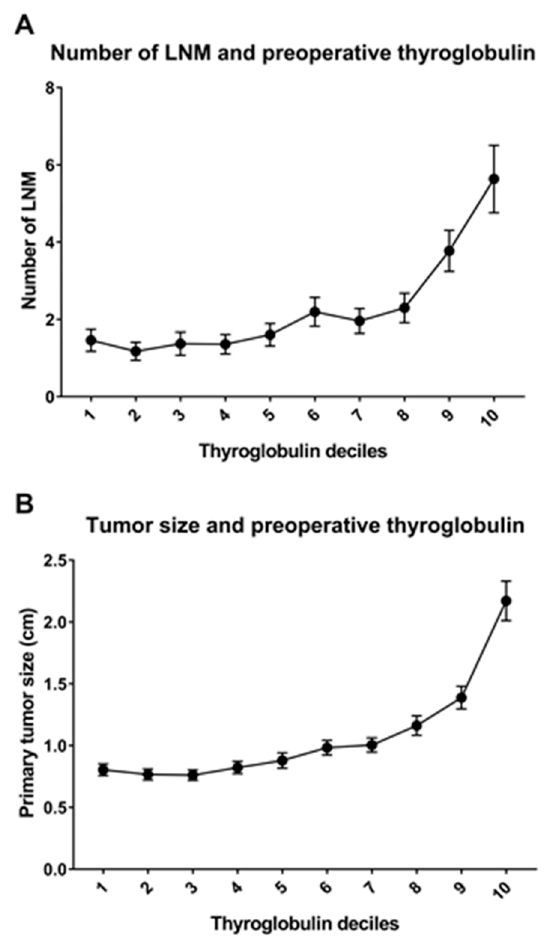
Figure 1. Correlation between tumor burden and preoperative thyroglobulin levels. There is a linear relationship between preoperative serum thyroglobulin and ( A ) the number of LNM and ( B ) the size of the primary tumor. In patients in the eighth and ninth decile of preoperative thyroglobulin levels, tumor size and the number of LNM increase sharply. Thyroglobulin deciles: the deciles of patients with different levels of preoperative thyroglobulin levels (levels increase from deciles 1 to 10).